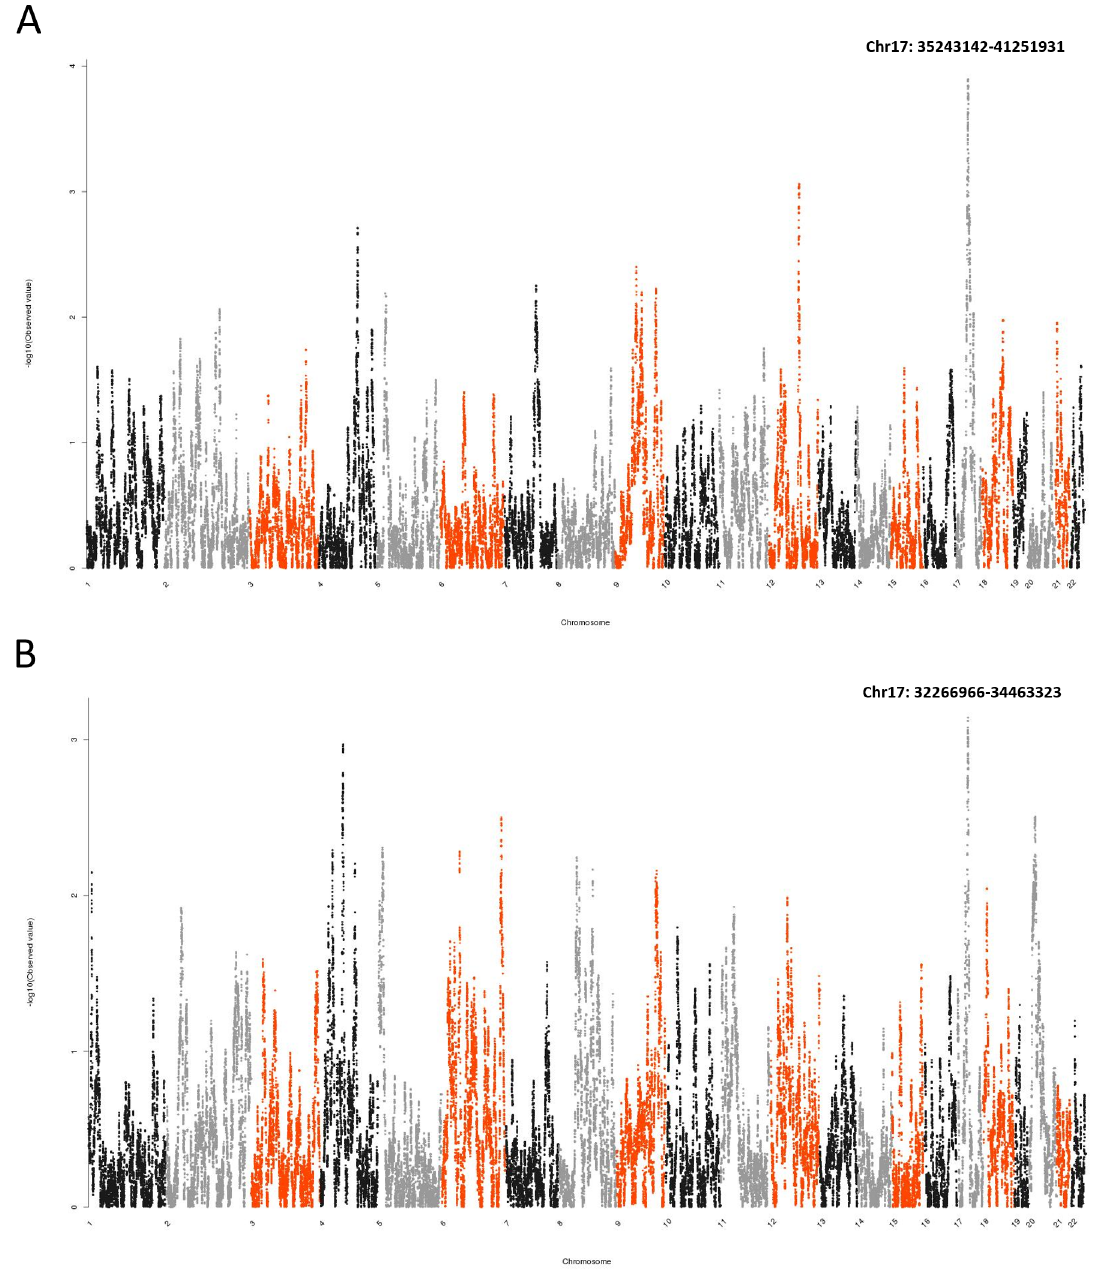
Fig 1. Manhattan plots showed associations between collateralization and local ancestry. (A) local Native American ancestry; (B) local African ancestry in admixturemapping. The peak regions of local Native Americanancestry and local African ancestry were both located on chromosome17. X-axis indicatedchromosomes 1 to 22. Y-axis indicated − log10of local Native American/African ancestry P-values.